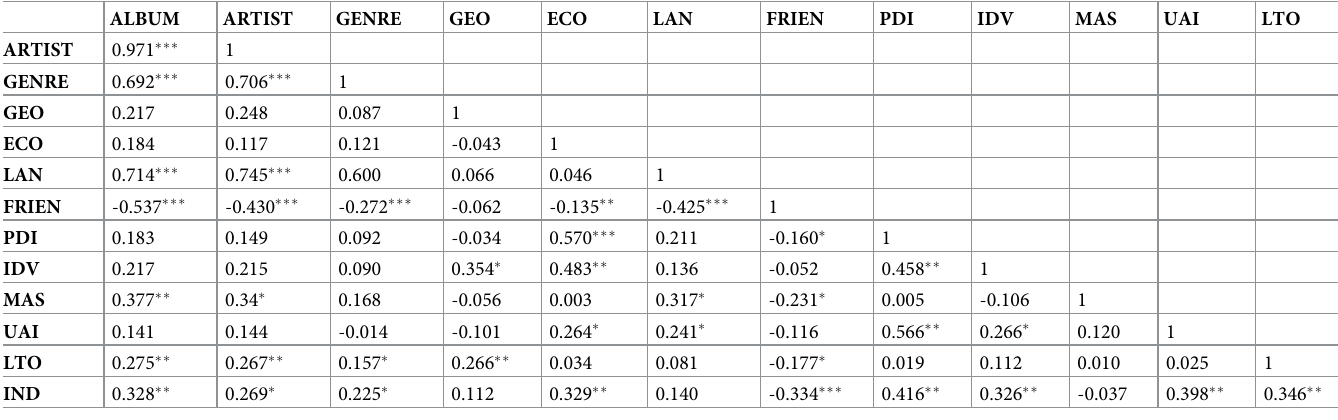
Table 1. The QAP correlation